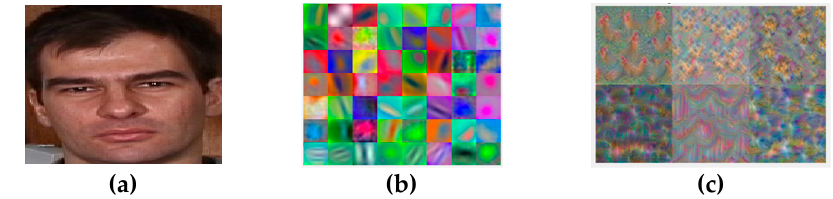
Figure 5. Feature visualization for CNN AlexNet on Georgia Tech face dataset: ( a ) input image; ( b ) features of first convolutional layer 'conv1'; ( c ) features of layer ‘fc7’.